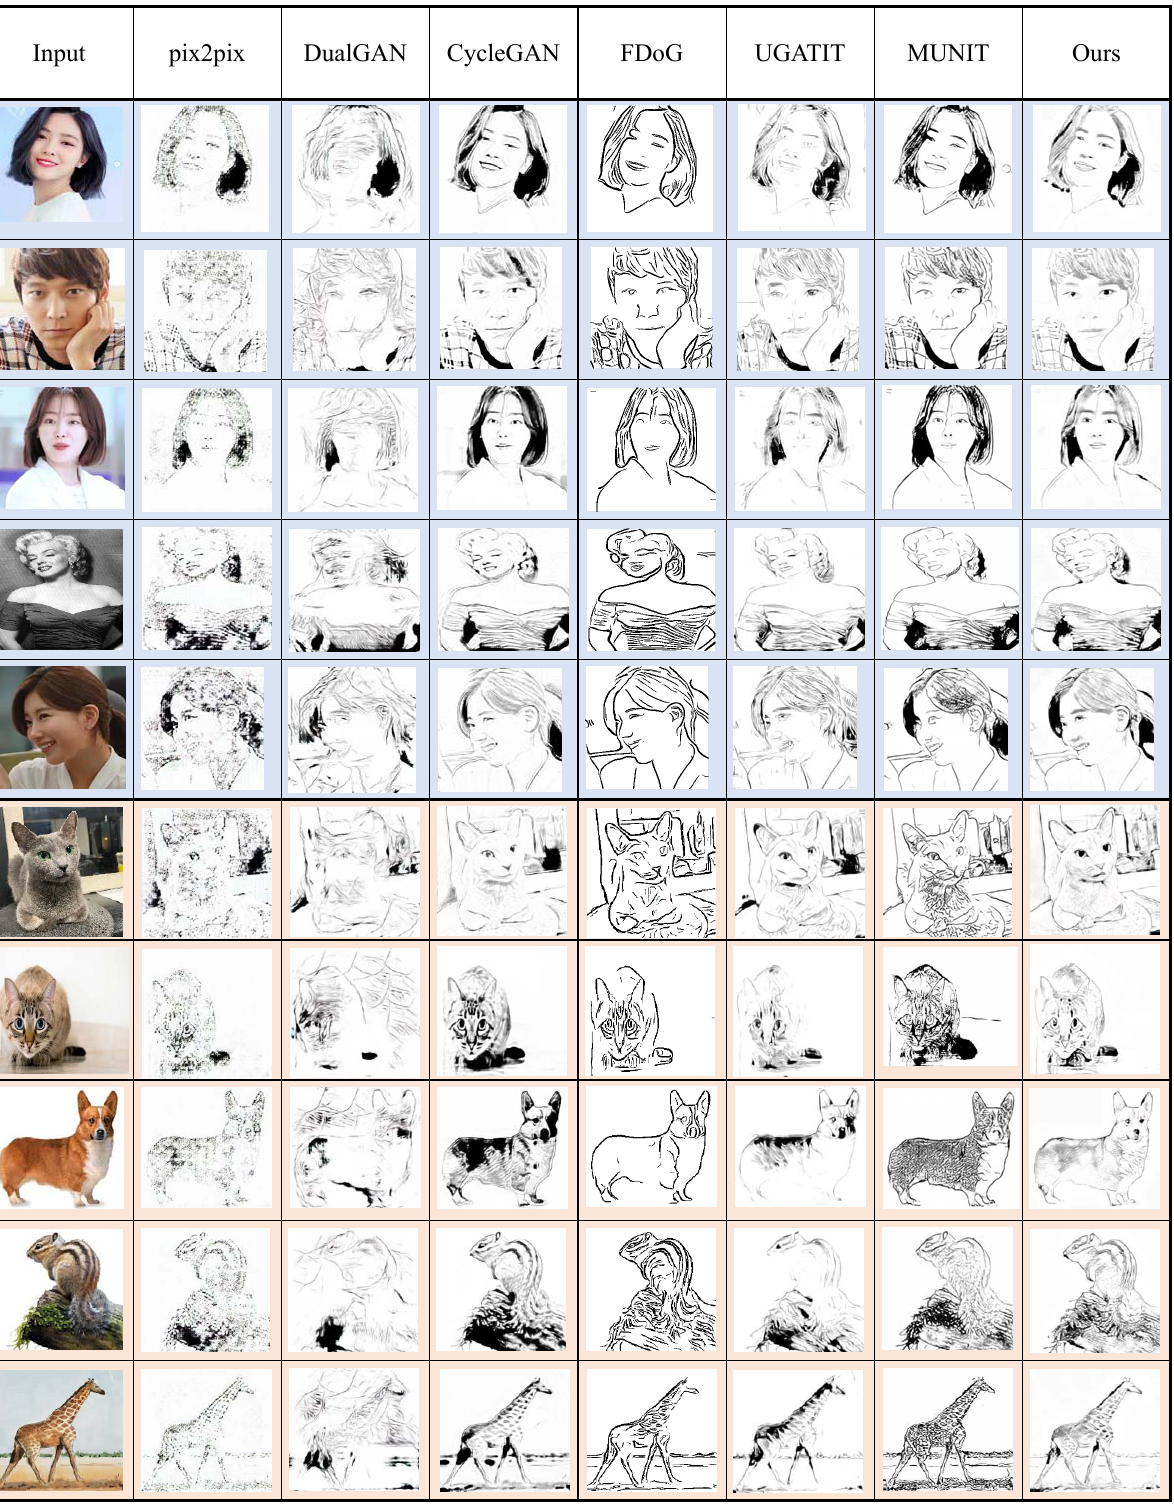
Figure 11. Our illustrative sketch images compared with existing works: The portraits are contained in blue cells and animals in